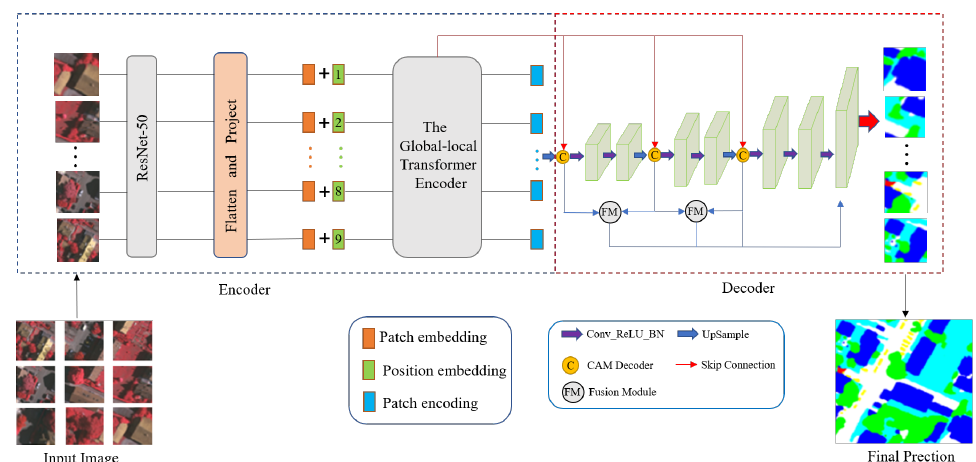
Figure 2. Overall structure diagram of the MCAFNet.